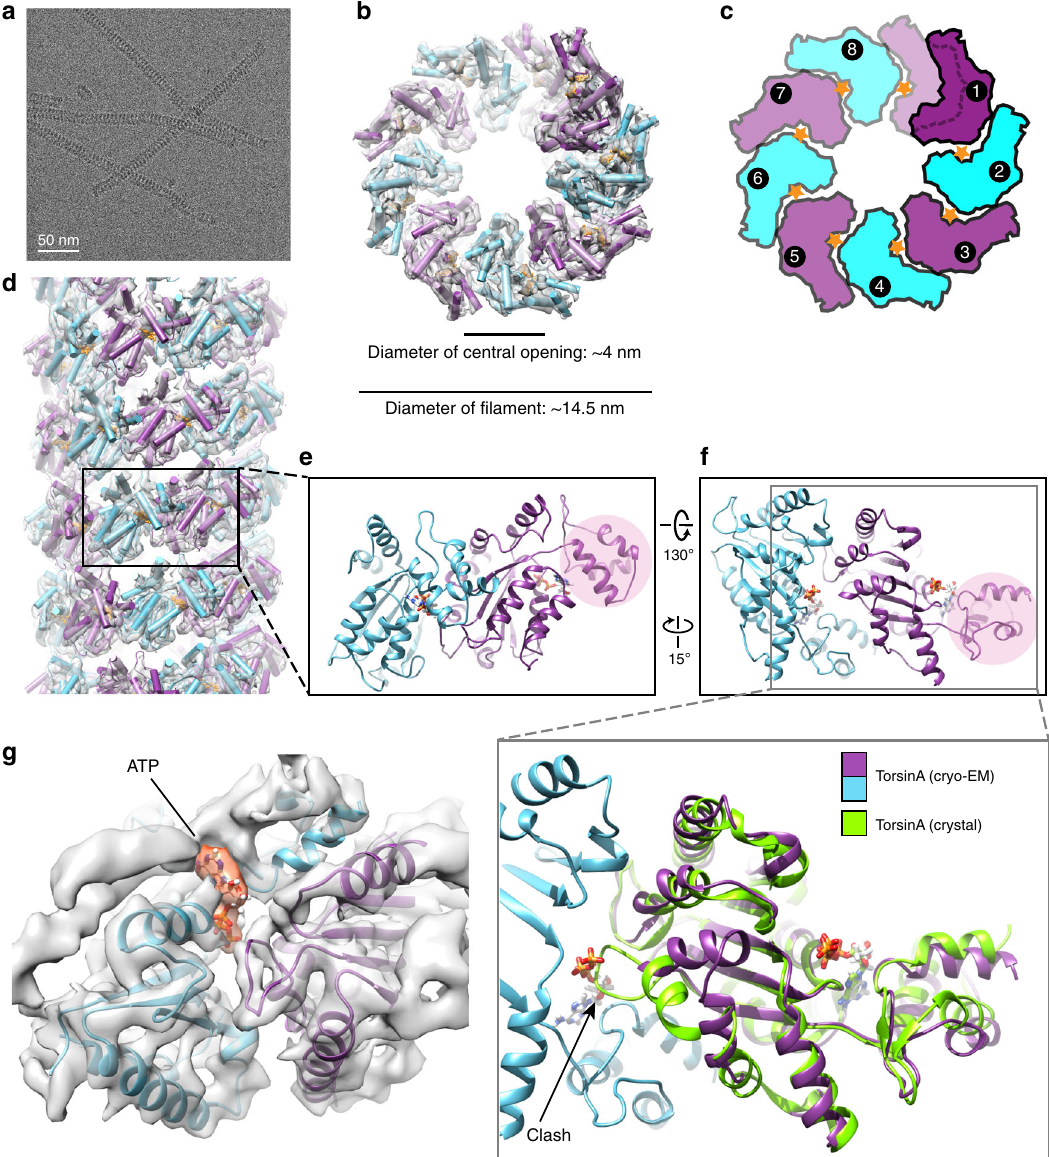
Fig. 1 Cryo-EM reconstruction of the TorsinA fi laments. a A cryoelectron micrograph of the TorsinA fi laments embedded in thin ice. b End view of the reconstructed helical tube fi tted into the cryo-EM density where TorsinA subunits are shown in alternating colors of purple and cyan, and ATP is shown in orange. c Schematic drawing of the TorsinA fi lament colored as in ( b ). Orange stars represent ATP molecules. A single helical turn contains 8.5 TorsinA subunits. d Side view of the reconstructed TorsinA tube depicted and colored as in ( b ). Cartoon representation of a TorsinA – TorsinA dimer element from within the helical tube is shown in two different orientations in ( e ) and ( f ). The small domain of a single TorsinA in the dimer is highlighted in pink. The previously determined crystal structure of TorsinA (PDB: 5j1s) is superposed on the TorsinA – TorsinA dimer in an enlarged view of ( f ). The non-catalytic face of TorsinA rearranges in the cryo-EM structure to avoid a steric clash with the nucleotide. g Nucleotide-binding region of the TorsinA – TorsinA dimer fi t into the cryo-EM density. Bound nucleotide is modeled as ATP and highlighted in orange color in the